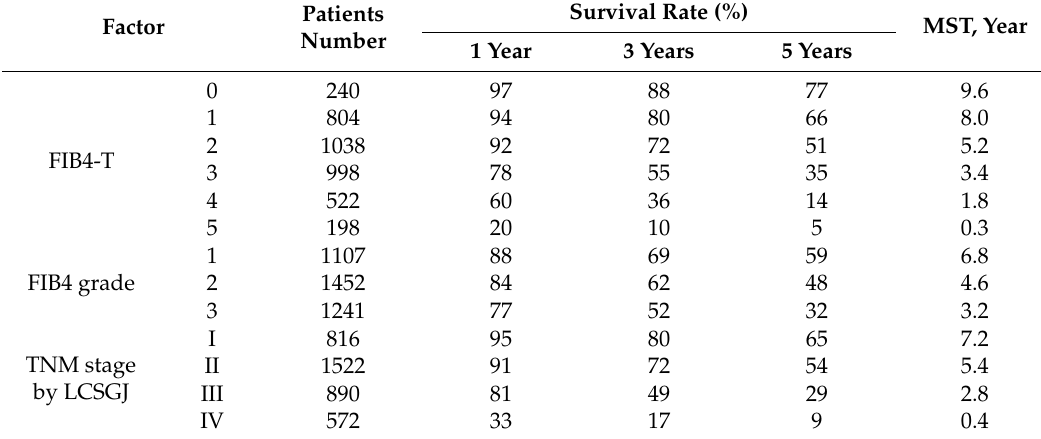
Table 3. Overall survival of HCC patients stratified by FIB4-T, FIB4 grade, and TNM.